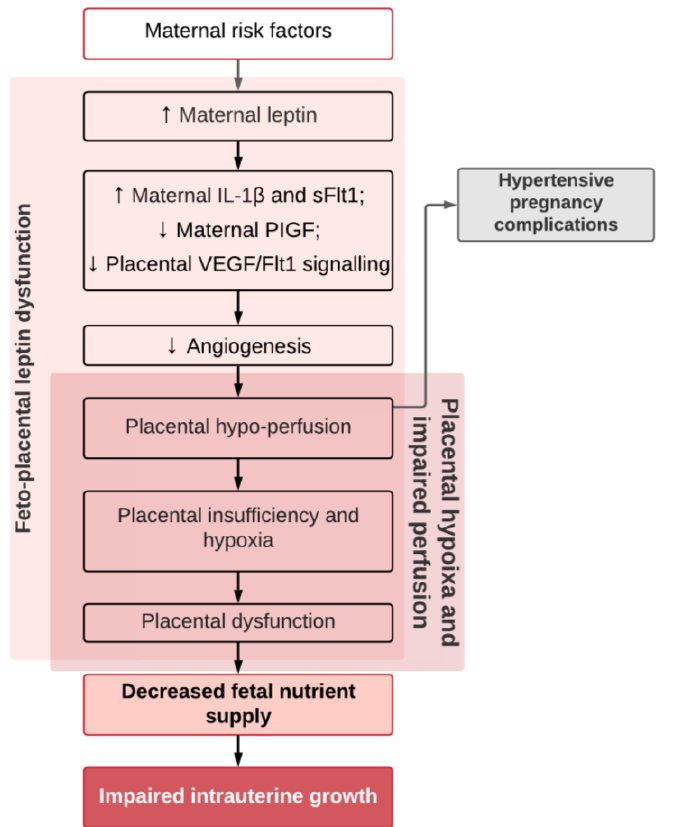
Figure 3. Leptin and dysangiogenesis in pre-eclampsia. Abbreviations: IL-1β: Interleukin-1 beta; sFlt1: Soluble Fms-like Tyrosine Kinase-1; PIGF: Placental Growth Factor; VEGF/Flt1: Vascular Endothelial Growth Factor/Fms-like Tyrosine Kinase-1.